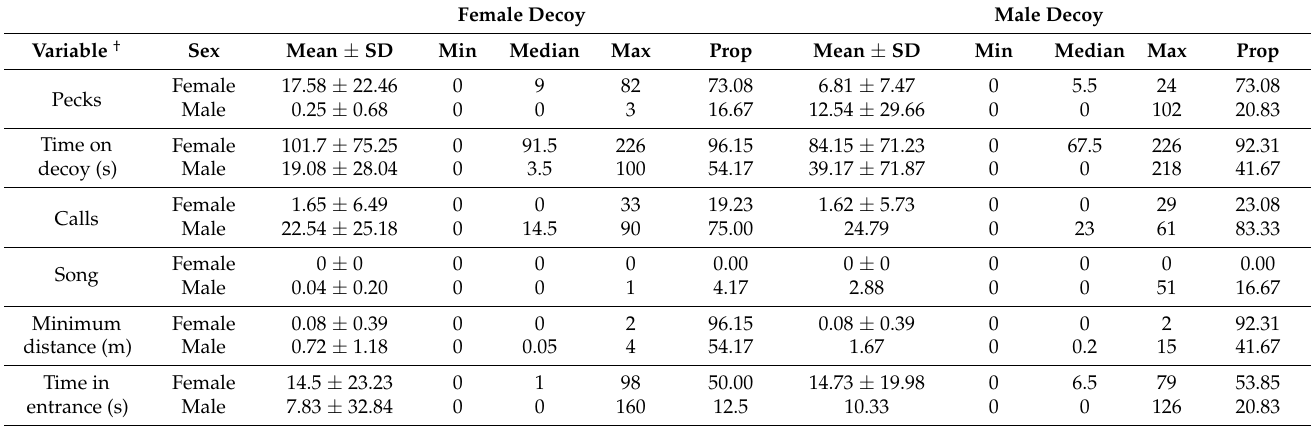
Table A1. Descriptive statistics of the aggression parameters scored during simulated territorial intrusions for both sexes and per decoy (N Female = 26; N Male = 24). Mean, standard deviation (SD), minimum (min), median and maximum (max) values are given. ‘Prop’ indicates the proportion of individuals which perform the behaviour during the simulated territorial intrusions. For the parameters ‘Time on decoy (s)’, ‘Time in entrance (s)’ and ‘Time in nest box (s)’, ‘prop’ refers to the proportion of tests in which individuals spent at least one second displaying the behaviour. For ‘Minimum distance (m)’, ‘prop’ indicates the proportion of individuals which perched on the